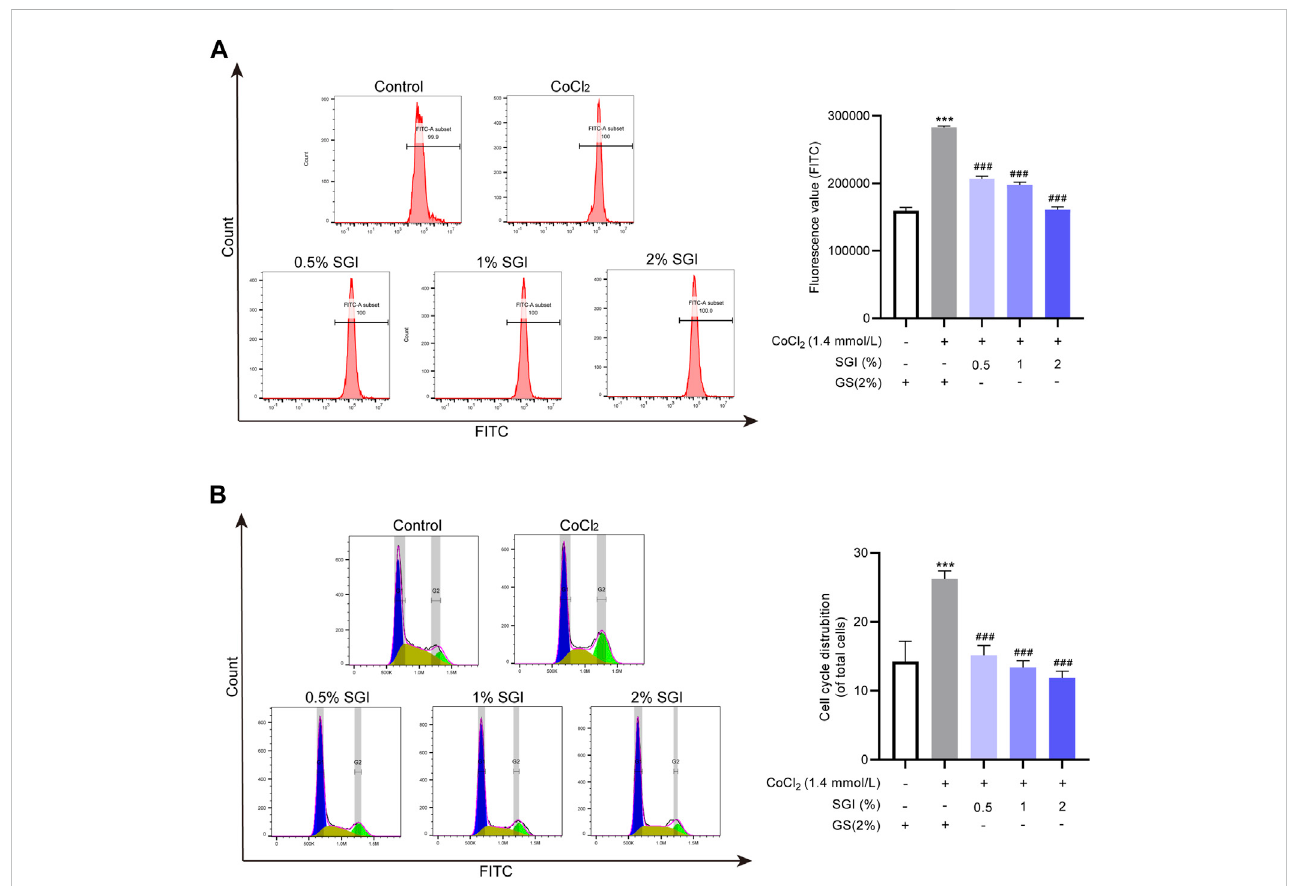
FIGURE 7 SGI decreases cytosolic Ca 2+ concentration and G2/M arrest. (A) Intracellular Ca 2+ concentration was assessed by fl ow cytometry. (B) The cell cycle was detected by fl ow cytometry. *** p < .001 vs. the control group; ### p < .001 vs. the CoCl 2 group.